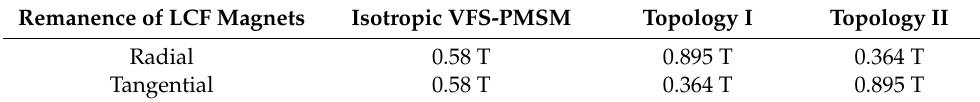
Table 2. Radial and tangential remanence of isotropic VFS-PMSM, Topology I, and Topology